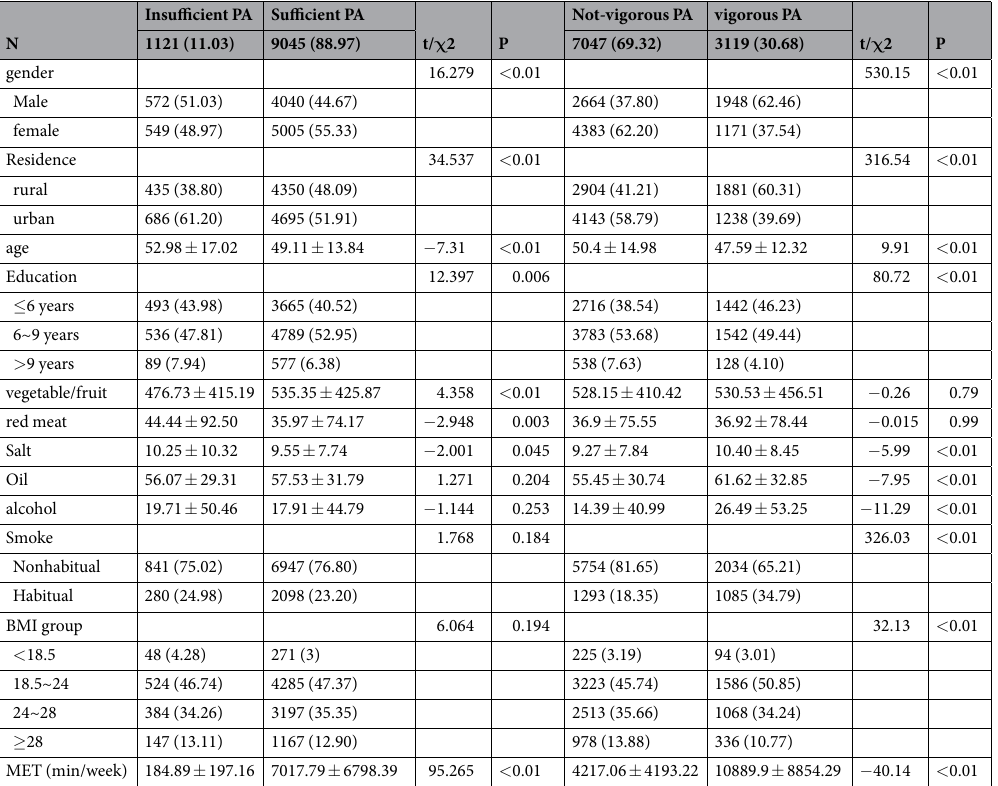
Table 1. Sociodemographic characteristics of participants in northwest China with sufficient/insufficient or vigorous/non-vigorous physical activity. Values are presented as n (%) or mean ± SD. Abbreviations: PA, physical activity; BMI, body mass index; MET, metabolic